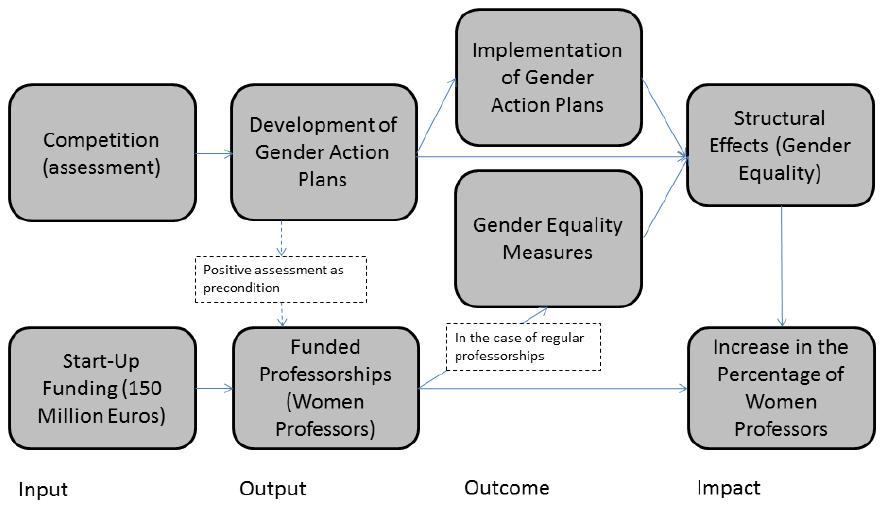
Figure 1. Program Figure 1. Program Theory.